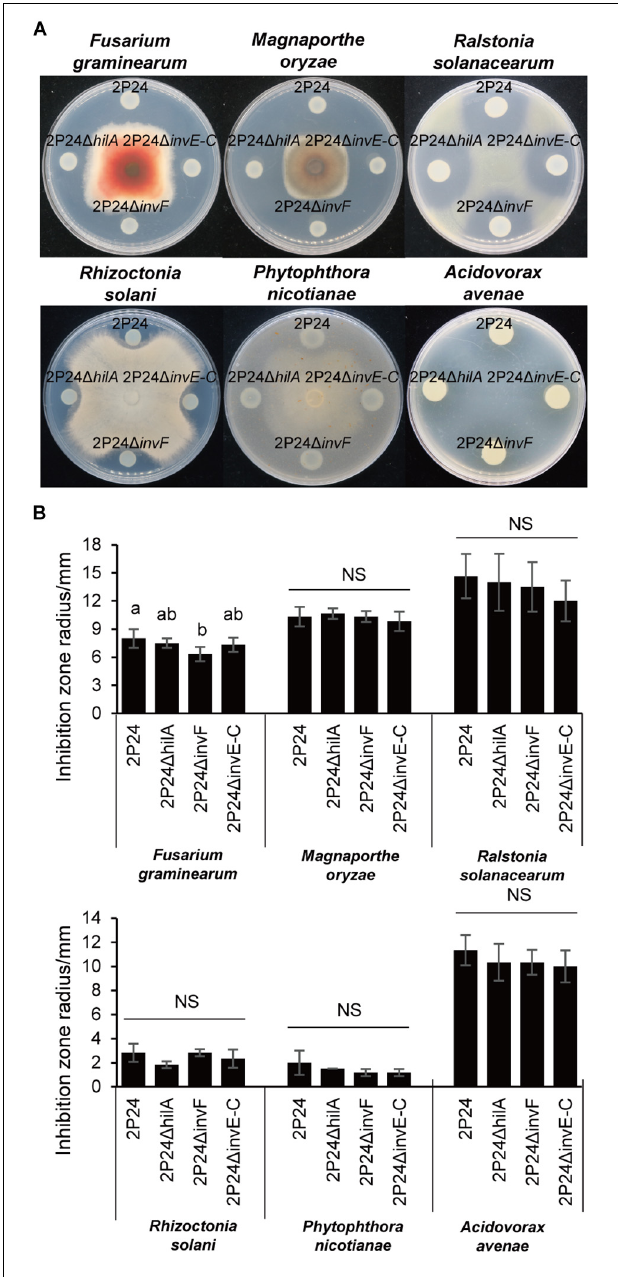
FIGURE 5 | Antagonism of strain 2P24 and SPI-1 related mutants to plant pathogens. (A) Antagonistic effect on pathogenic fungi Fusarium graminearum , Magnaporthe oryzae , Rhizoctonia solani , and Phytophthora nicotianae and pathogenic bacteria Ralstonia solanacearum and Acidovorax avenae . (B) Quantitative analysis of antagonistic effect. Data are means of three replicates. Error bars represent SD. Means shown with the same letters are not different statistically at the 5% confidence level on the basis of Duncan’s multiple range test. NS means no significant difference.